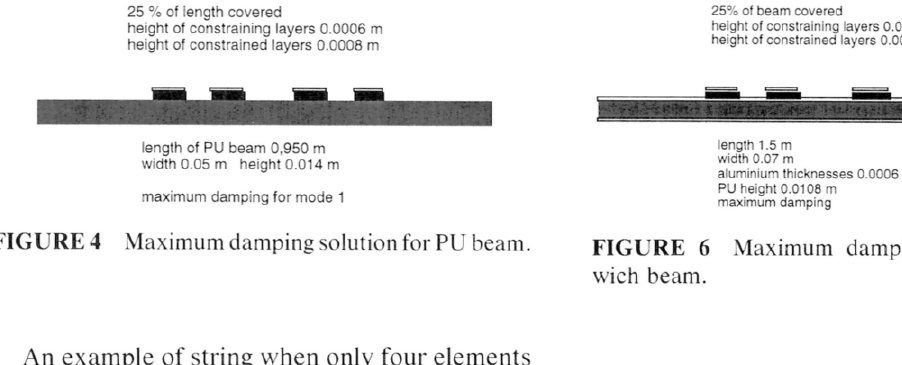
FIGURE 6 Maximum damping solution for sand wich beam.